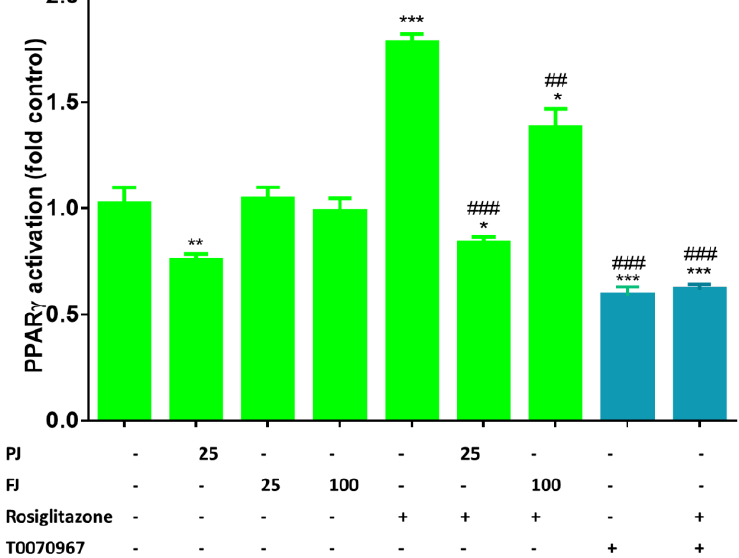
Figure 12. The e ff ect of V. opulus FJ (25 and 100 µ g / mL) and PJ (25 µ g / mL) preparations on PPAR γ activation in GeneBLAzer ® PPAR gamma 293H DA reporter gene assay; as agonist 1 µ M rosiglitazone was used, whereas as antagonist 1 µ M T0070967; the control cells were not exposed to any compound; the values are means ± standard deviations, n = 4; the statistical significance was calculated versus control cells with * p ≤ 0.05, ** p ≤ 0.01, *** p ≤ 0.001; the statistical significance was calculated versus cells after rosiglitazone treatment with ## p ≤ 0.01, ### p ≤ 0.001.